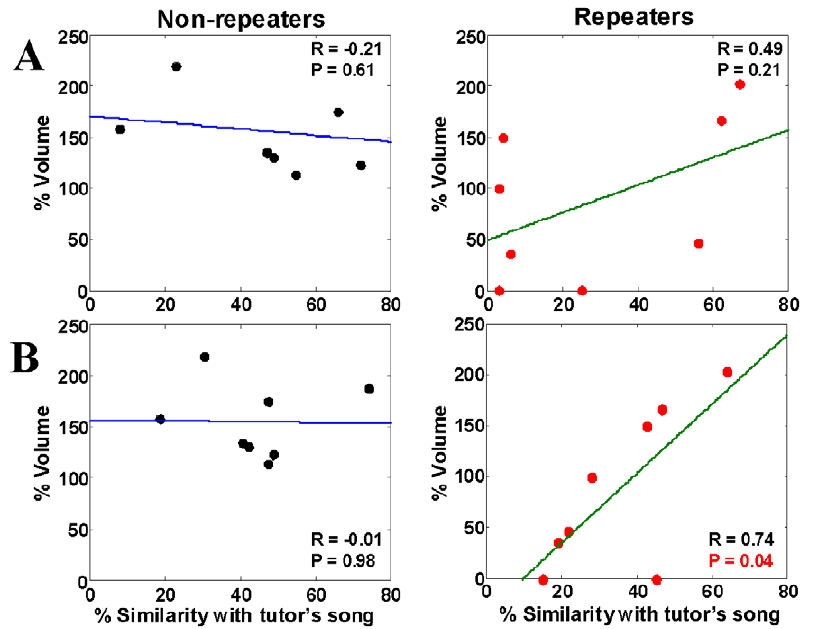
Figure 5. Correlation of BOLD response with tutor’s song similarity. The volume of response to TUT in non-repeaters and repeaters, expressed as a percentage of the mean of all stimuli in each bird, is plotted as a function of the % similarity of the pupil’s song with that of its tutor. The % similarity values obtained with the asymmetric time course motif comparison method (A) using the Sound Analysis Pro program [25,26] show no statistically significant correlation in repeaters (red dots) or non-repeaters (black dots); however, values obtained using the symmetric method (B) shows positive linear correlation in repeaters, but not in non-repeaters. Linear fit to the data is indicated by the blue and green lines.